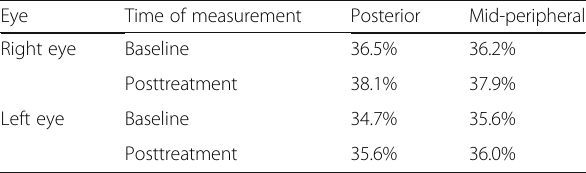
Table 1 Densities of retinal and choroidal vessels Eye Time of measurement Posterior Mid-peripheral Right eye